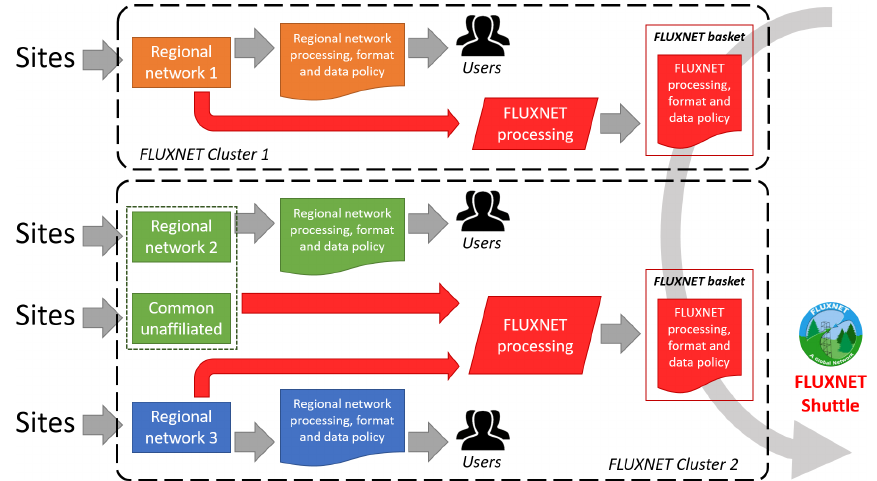
Figure 2. Data flow from the sites to the FLUXNET shuttle. The sites submit the data to the regional networks with which they are associated or, maybe for a temporary period, to a common system for unaffiliated sites that are managed by one of the regional networks (in the figure the regional network 2). Each regional network can organize its own data processing, data policy and data distribution system. Part of the data is then also processed using the standard FLUXNET processing and then shared in the FLUXNET basket where the FLUXNET shuttle can collect if for the user upon request. The data shared in the FLUXNET shuttle are defined by the data owner. Note that the clusters can be also composed by a single regional network (like for regional network 1 in the figure) if the resources are sufficient to maintain